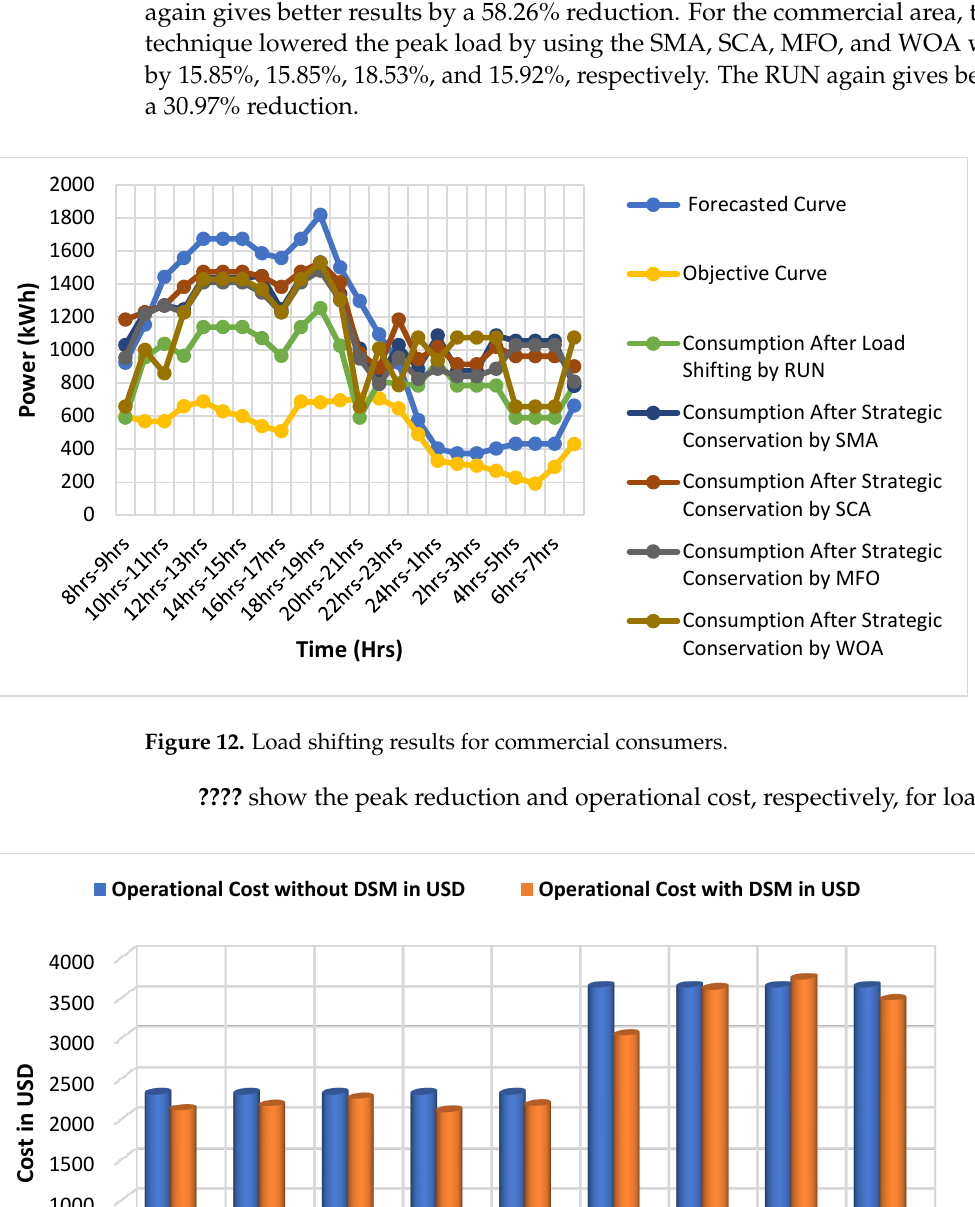
Figure 11. Load shifting results for residential consumers. Figure 12 reported the simulation results for the commercial area by load shifting.